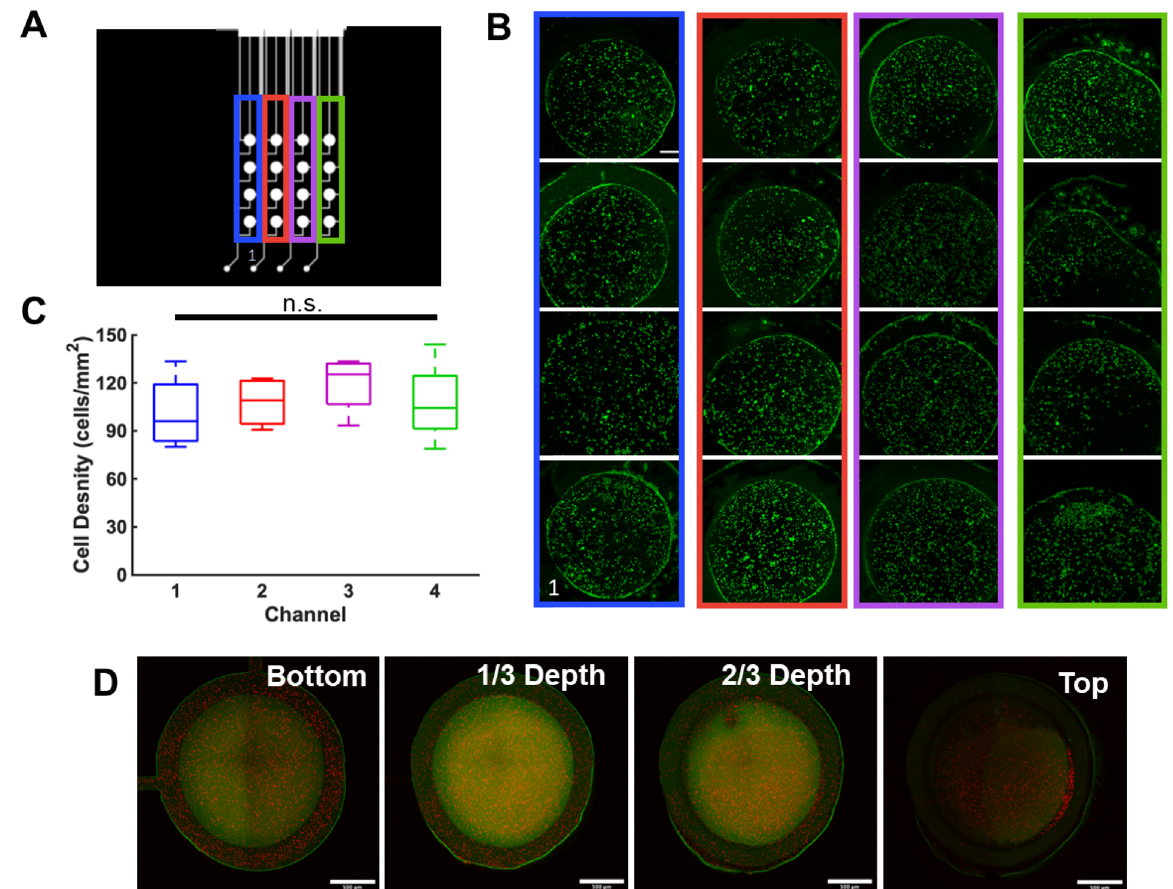
Figure 5. Cell loading reproducibility. ( A ) Device schematic of loading ports and channels and the cell culture microwells, where each column of cell culture chambers is color coded, starting with column 1 in blue. ( B ) Fluorescent images of the cell culture chambers loaded with hydrogels with entrapped U87 cells stained with DiOC. Scale bar = 200 µm. ( C ) Density of cells within the cell culture microwells of each column. ( D ) Images of the bottom, one-third, two-thirds, and the top of a hydrogel when loaded in a cell culture microwell. The hydrogels are labelled with green fluorescence via tethering of FITC-modified ligands to the 4-arm PEG-Ac. Scale bar = 500